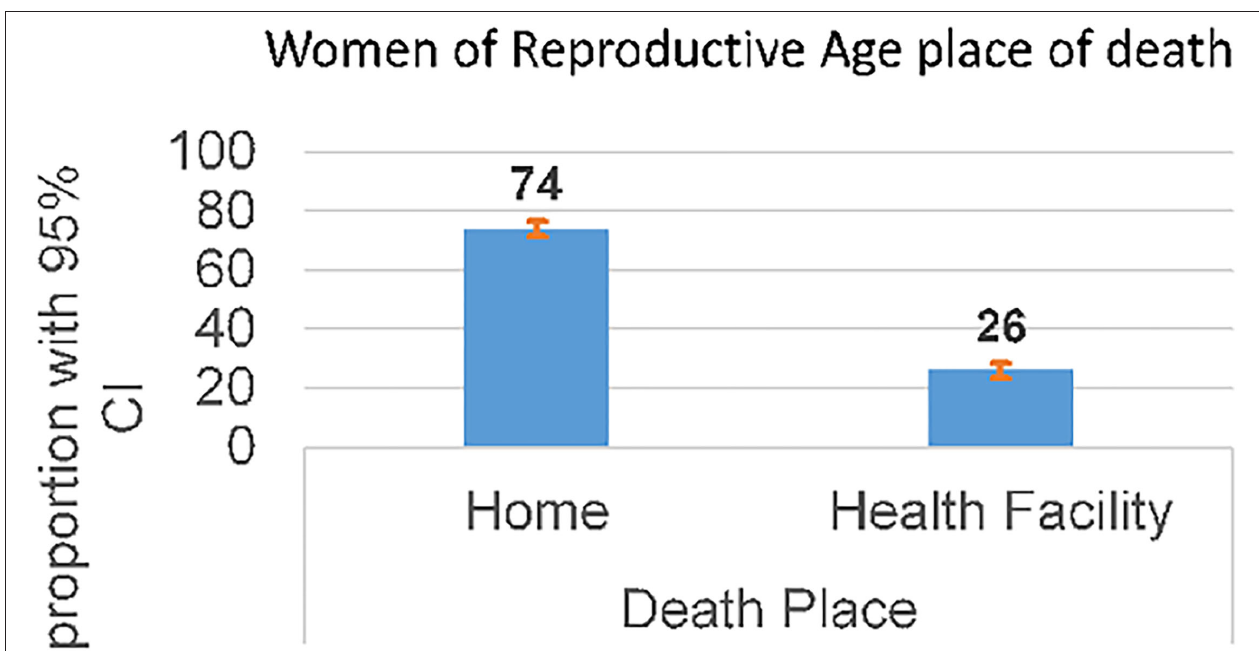
FIGURE 3 | Place of delivery of reproductive age women mortalities in KHDSS, eastern Ethiopia